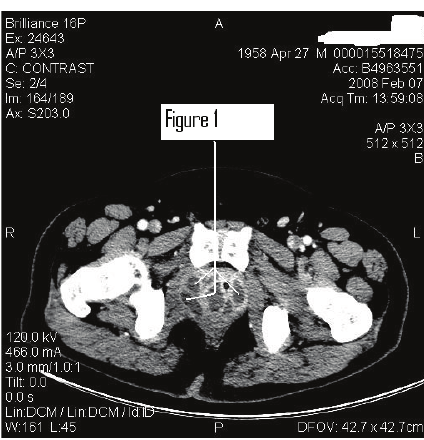
Figure 1: Computed tomography of the pelvis demonstrating mul- tiple prostatic abscesses of varying